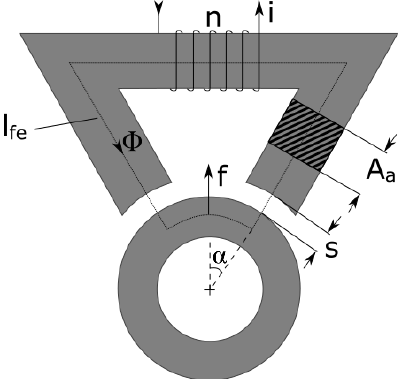
Figure 1. Force and geometry of a radial magnet, adopted from